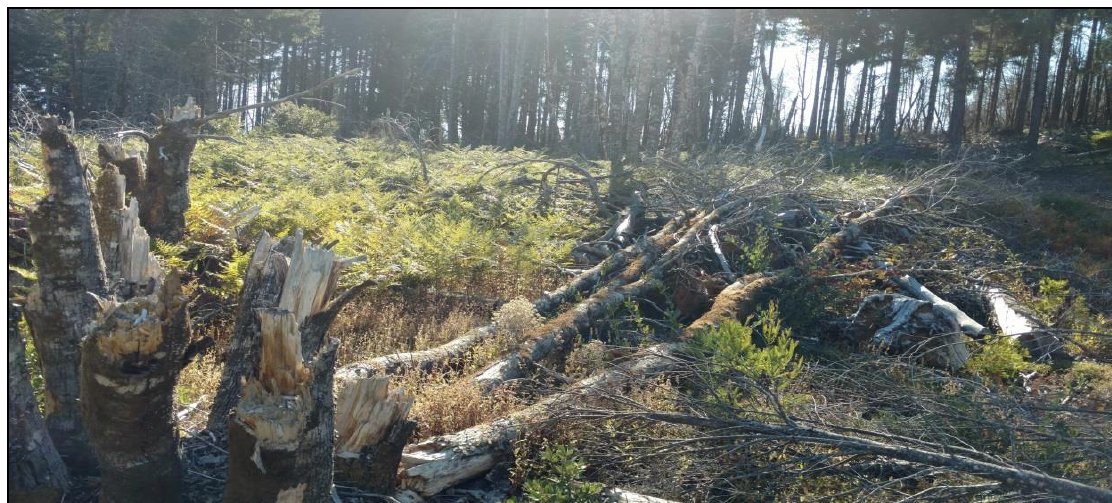
Figure 1. Fallen tanoak stems originating from stump sprout clumps, five years after forest rehabilitation frill treatment and enrichment planting of coast redwood ( Sequoia sempervirens ) outside its natural range to supplement natural regeneration of Douglas-fir seeding in from forest edge in background.